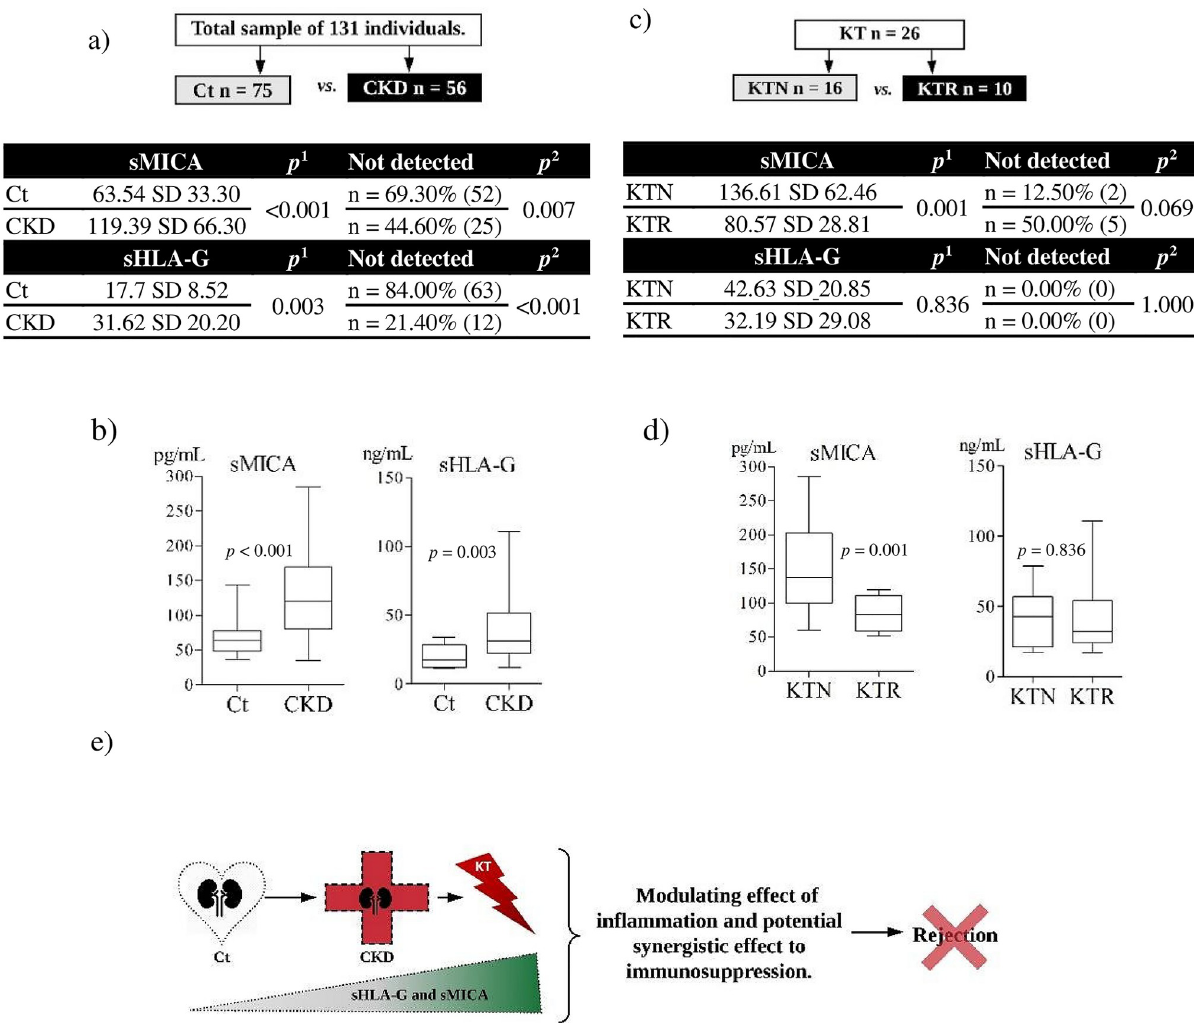
Fig 2. Case-control analysis of sMICA and sHLA-G production. Analyses of sMICA and sHLA-G were performed for control (Ct) versus chronic kidney disease (CKD) (a-b) , and after kidney transplant (KT) in patients with (KTR) and without (KTN) episodes of rejection (c-d) . The production of regulatory molecules, sHLA-G and sMICA, is stimulated in a pathological condition, such as in patients with chronic kidney disease (CKD), but generally not in individuals in homeostasis, as observed in Ct. Once the CKD is established, the regulatory molecules in the pre-transplant can act in the post-transplant period as enhancers of immunoregulation, leading to allograft acceptance (e) . Mann-Whitney test 1 . Chi-square test 2 . SD: Standard deviation.